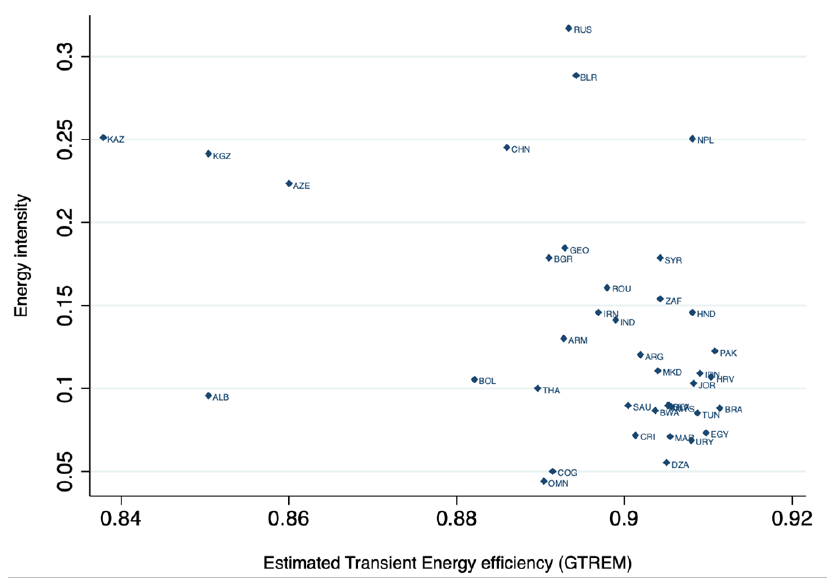
Figure 3. Estimated average energy efficiency Vs. average energy intensity